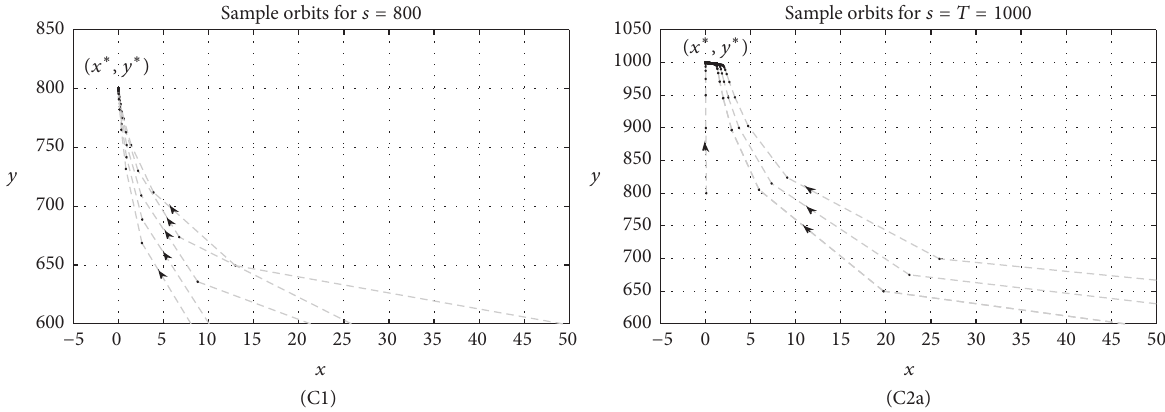
Figure 1: Examples illustrating conditions (C1) and (C2) from Table 1.